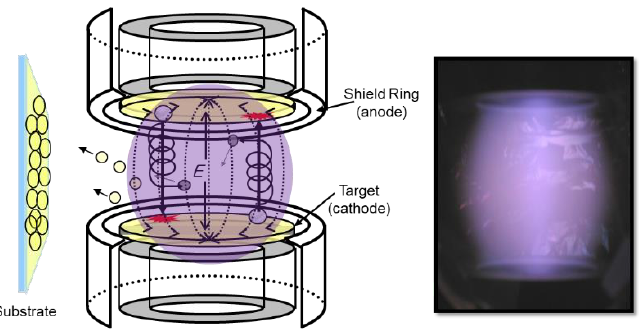
Figure 1. Schematic of the facing targets sputtering system.